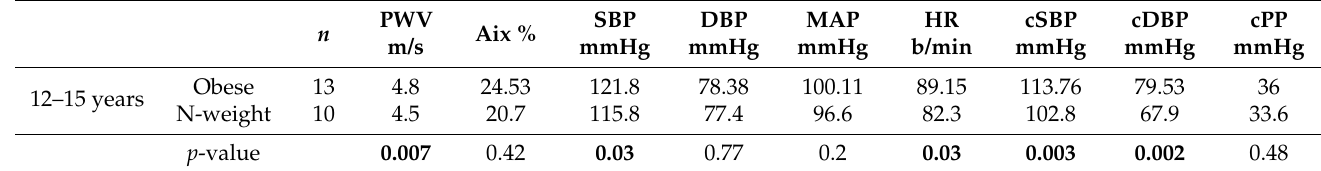
Table 8. PWA parameters comparison in subjects aged 12–15 years old.